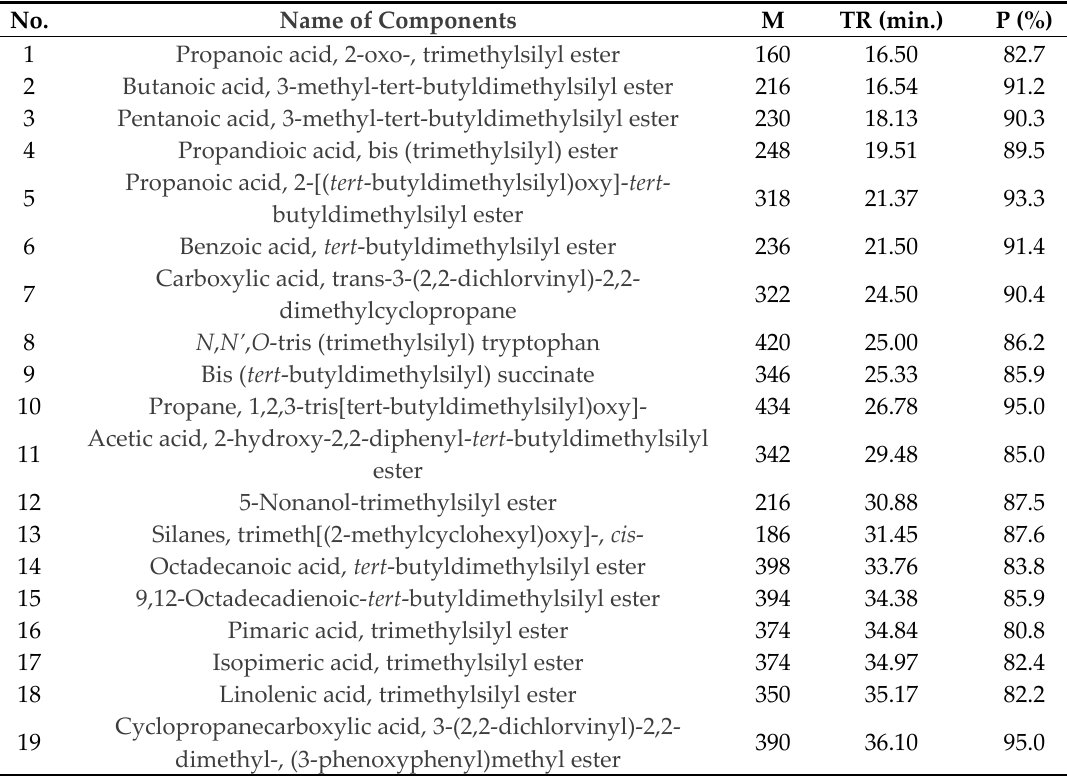
Table 2. The derivatized organic compounds from the residual liquor